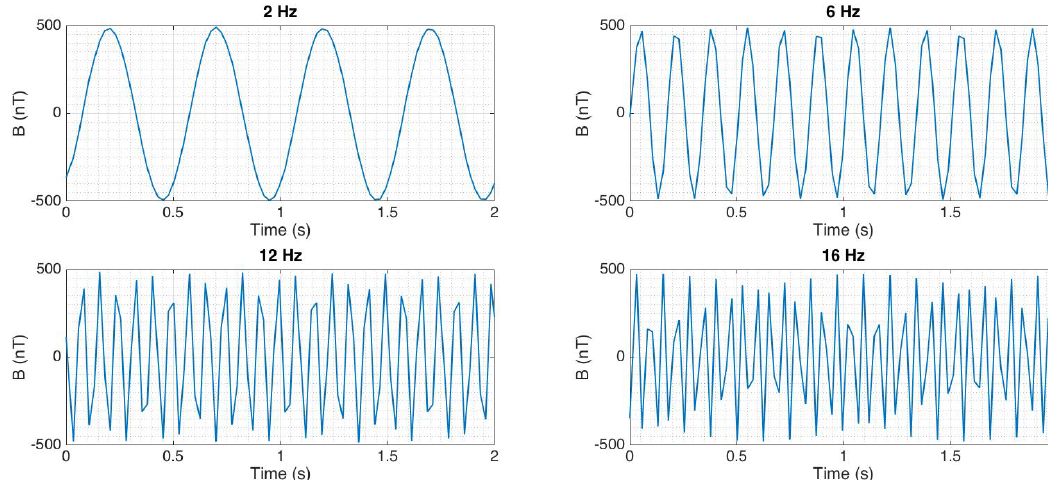
Figure 13. Detected signals for four different